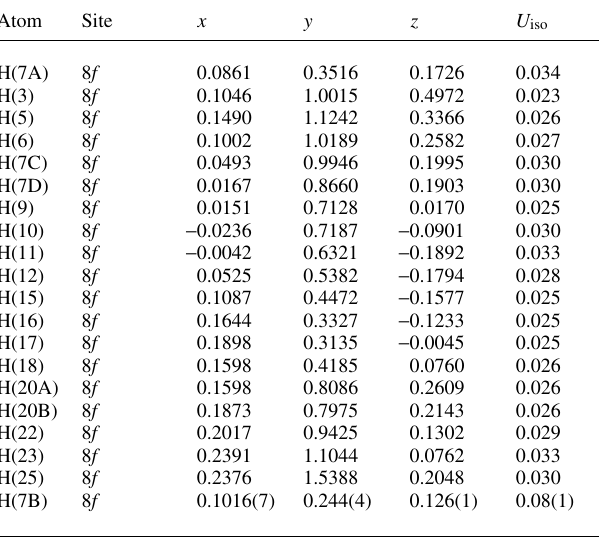
Table 2. Atomic coordinates and displacement parameters (in Å 2 )